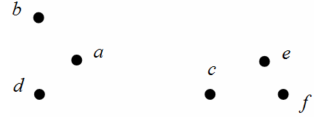
Figure 1. The deployment of six